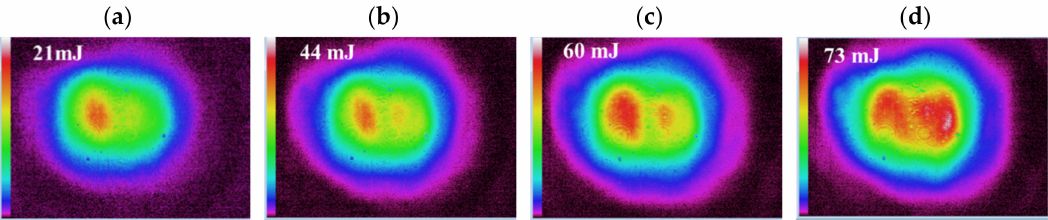
Figure 3. Beam profile of the amplified uncompressed laser pulse with different output energies: ( a ) 21 mJ, ( b ) 44 mJ, ( c ) 60 mJ, and ( d ) 73 mJ. The beam dimension for 73 mJ is approximately 4.2 mm × 5.0 mm and the central part of the beam is almost saturated already in this high-energy